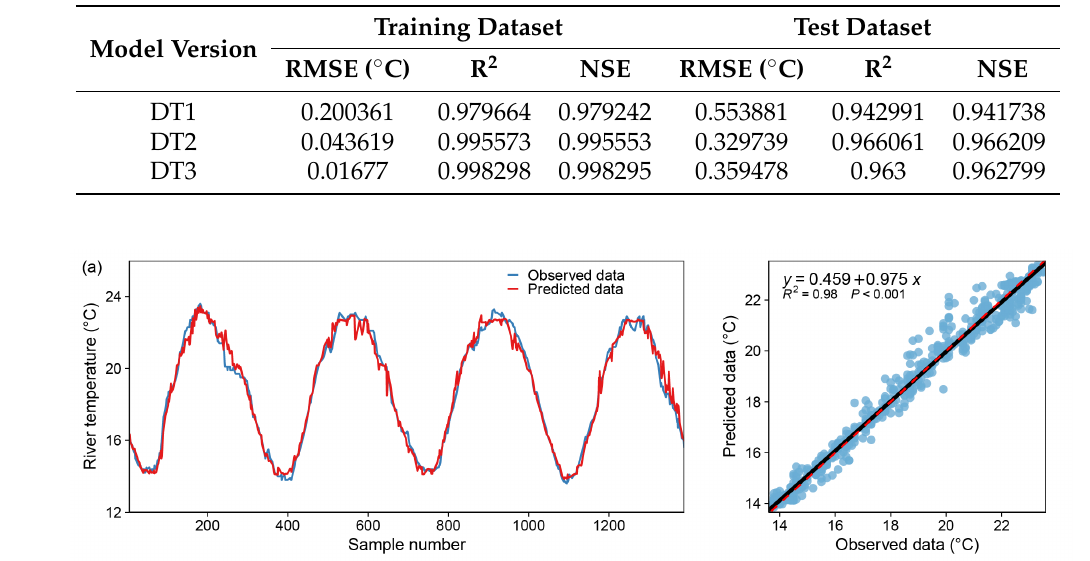
Table 2. Performances of DecisionTree Regressor in modeling water temperature (WT: ◦ C), DT1: only one input variable (DOY), DT2: with two input variables (DOY and Flow), DT3: with all input variables.